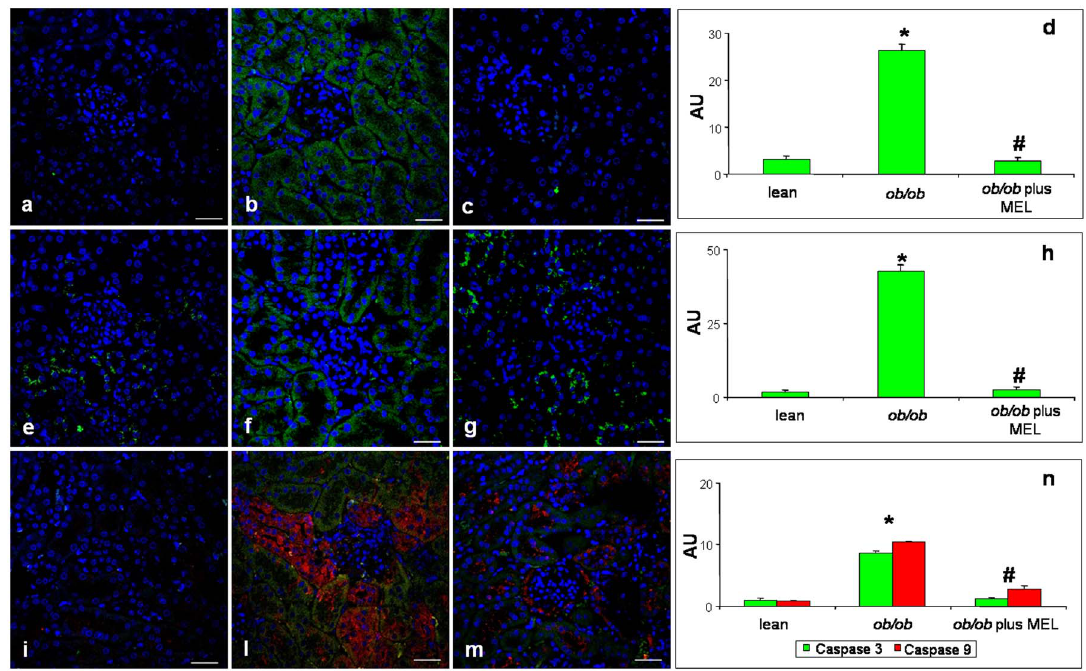
Figure 4. Apoptotic markers immunofluorescence assay. Photomicrographs of immunofluorescence analyses of kidney cytochrome c (green staining) of lean (a), ob/ob (b) and ob/ob treated with melatonin (c) mice. Immunofluorescence analyses of Bax (green staining) in kidney of lean (e), ob/ob (f) and ob/ob treated with melatonin (g) mice. Double immunofluorescence of caspase 3 (green staining) and caspase 9 (red staining) in kidney of lean (i), ob/ob (l) and ob/ob treated with melatonin (m) mice. Nuclei were stained with 4,6 diamidino-2-phenilindole. Bar equals 20 m m. The graphs summarize the quantitative analysis, respectively, of cytochrome c (d), Bax (h) and both caspase 3 and caspase 9 (n). * p , 0.05 vs lean and # p , 0.05 vs